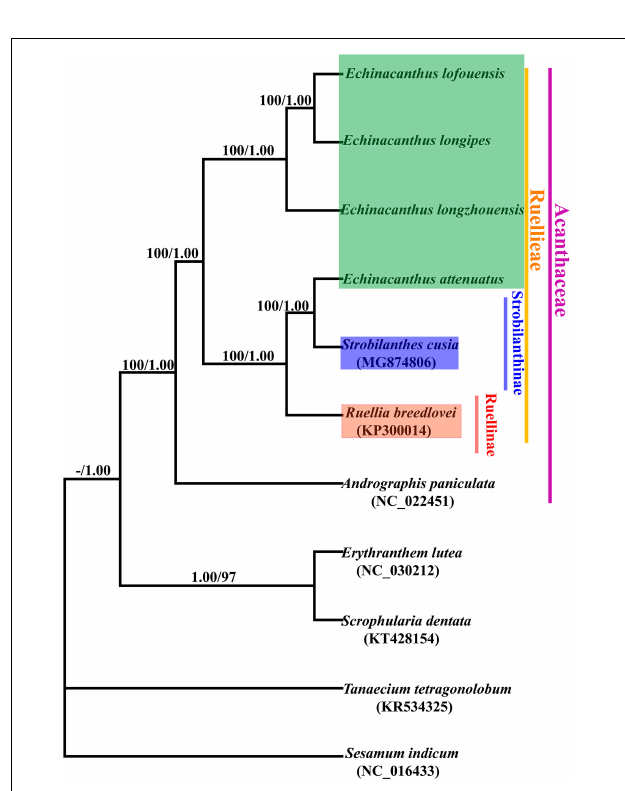
FIGURE 6 | Phylogenetic tree conducted using Bayesian Inference (BI) and most parsimonious (MP) methods based on whole complete genomes from different species. The numbers above branches represent posterior probability (PP)/bootstrap percentage